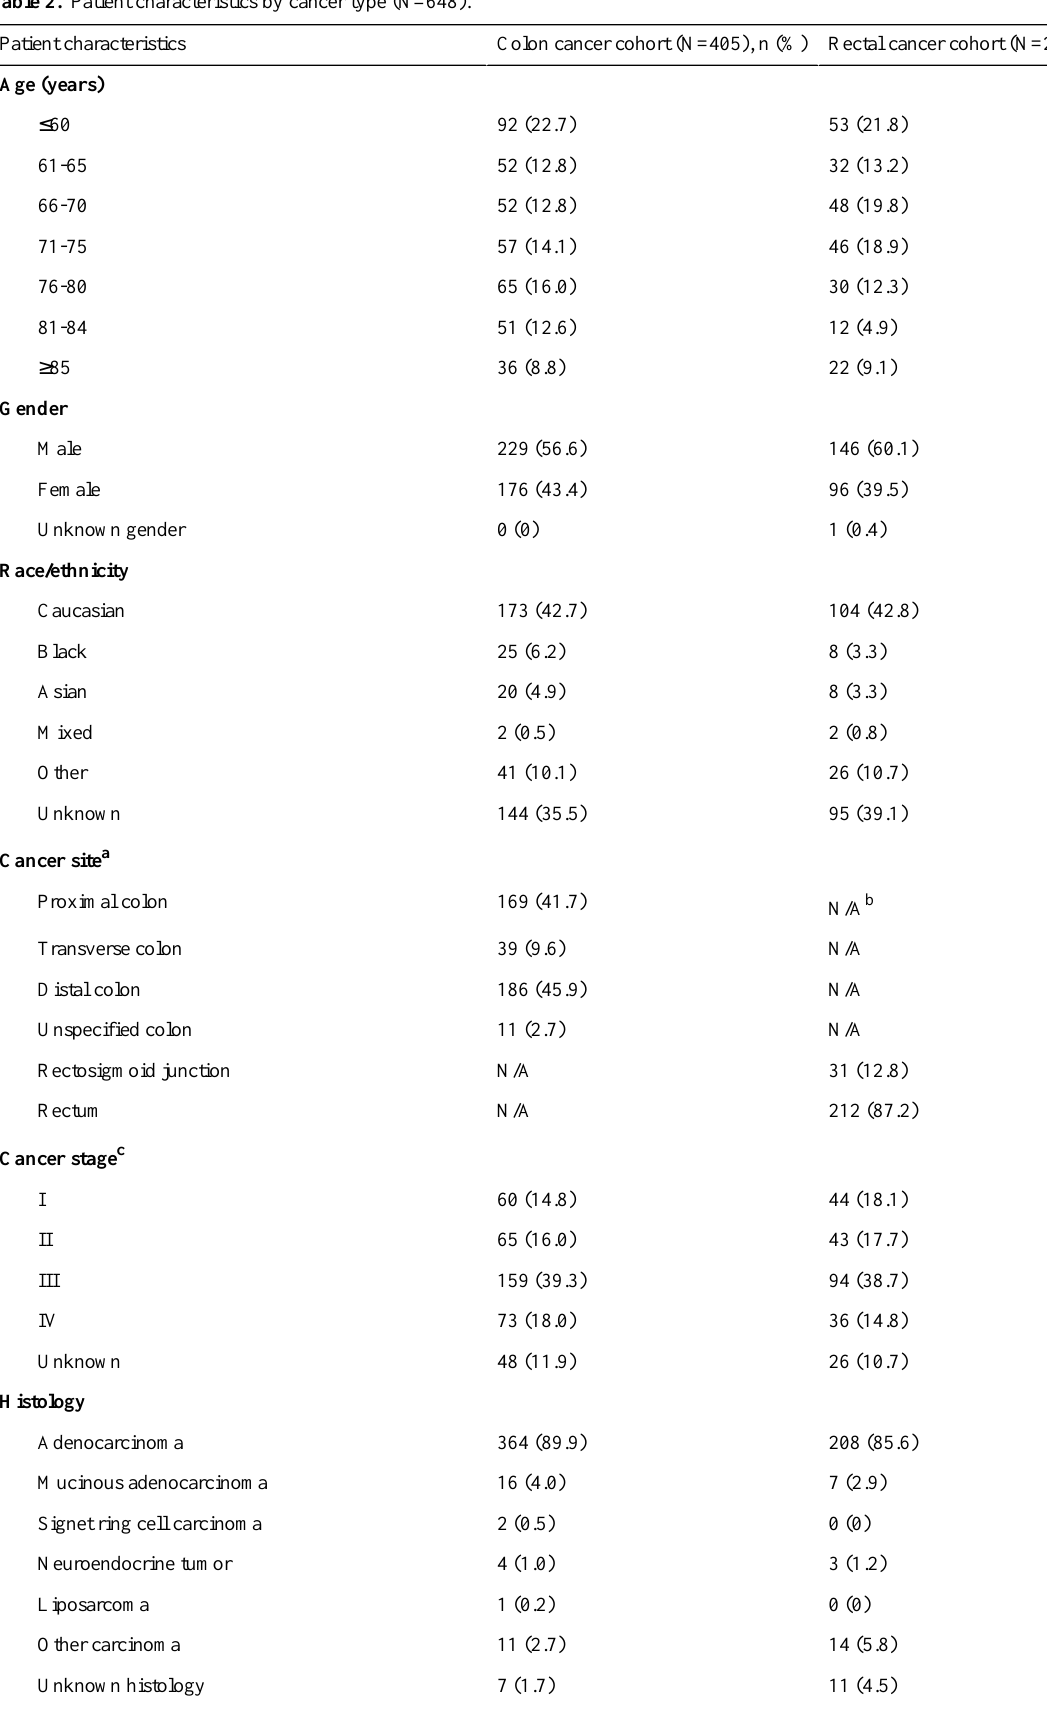
Table 2. Patient characteristics by cancer type